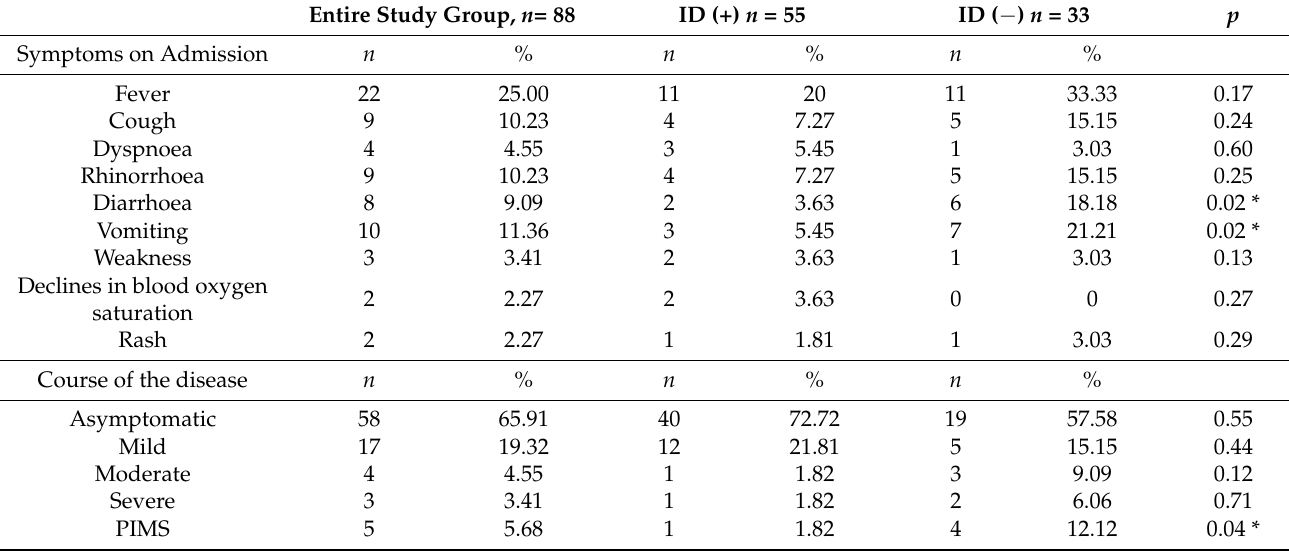
Table 5. Symptoms on admission and the course of COVID-19 in children with and without